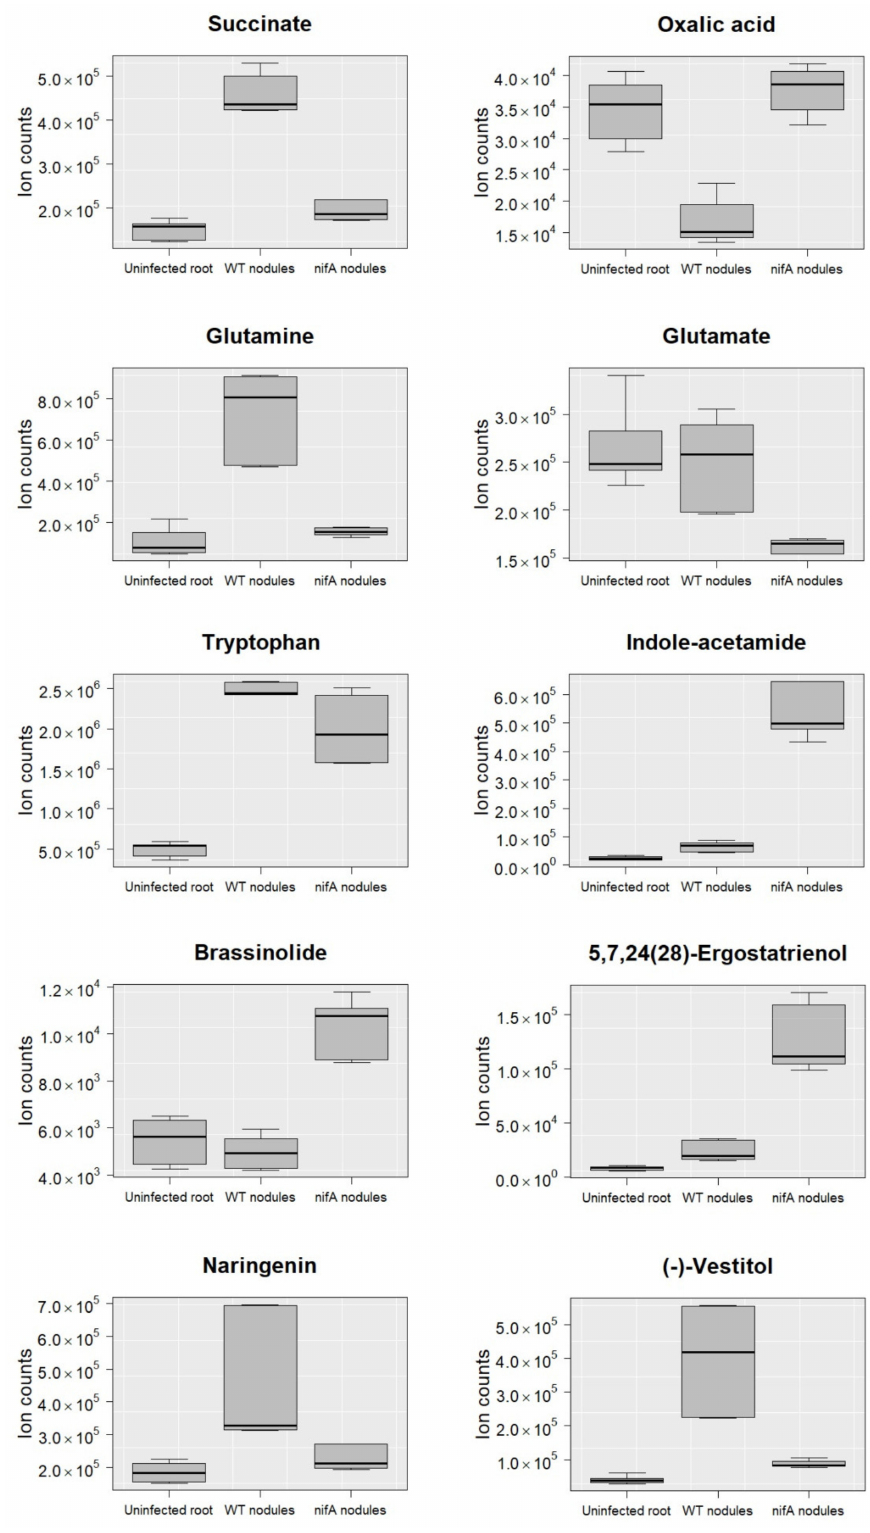
Figure 2. Comparison of the ion counts detected for each metabolite in uninfected bean roots (Uninfected root), nodules infected with P. phymatum wild-type (WT nodules) and nodules infected with P. phymatum nifA mutant (nifA nodules). The following compounds were examined: succinate, oxalic acid, glutamine, glutamate, tryptophan, indole-acetamide, brassinolide, 5,7,24(28)-ergostatrienol, naringenin and ( − )-vestitol. Three biological replicates with two technical replicates were analyzed and are shown as boxplots (median in